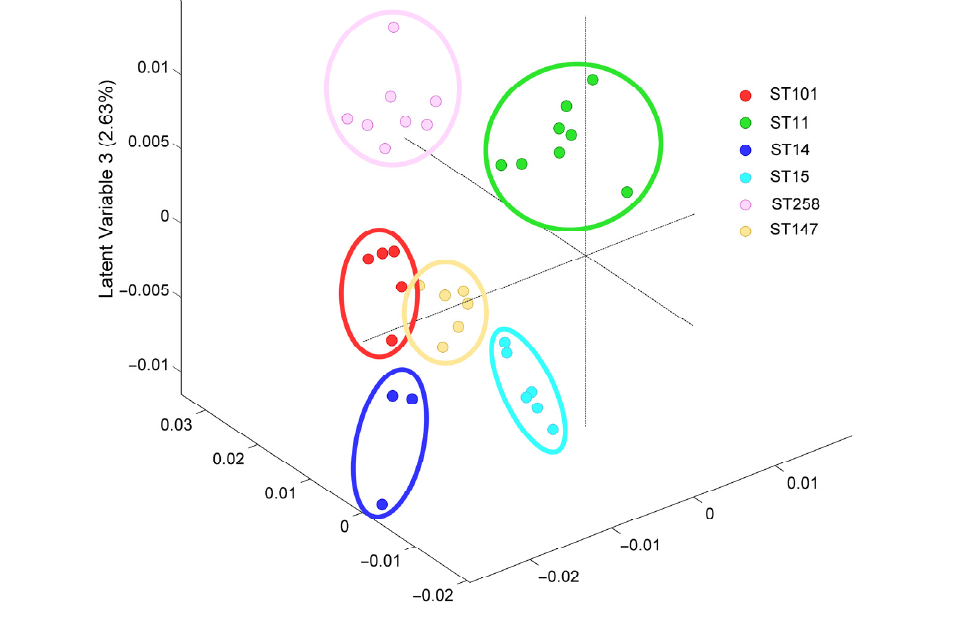
Figure 5. Discrimination of K. pneumoniae clones by SERS. Score plot of the PLSDA classification model with three latent variables (LVs) showing differentiation of Raman spectra according to the sequence type